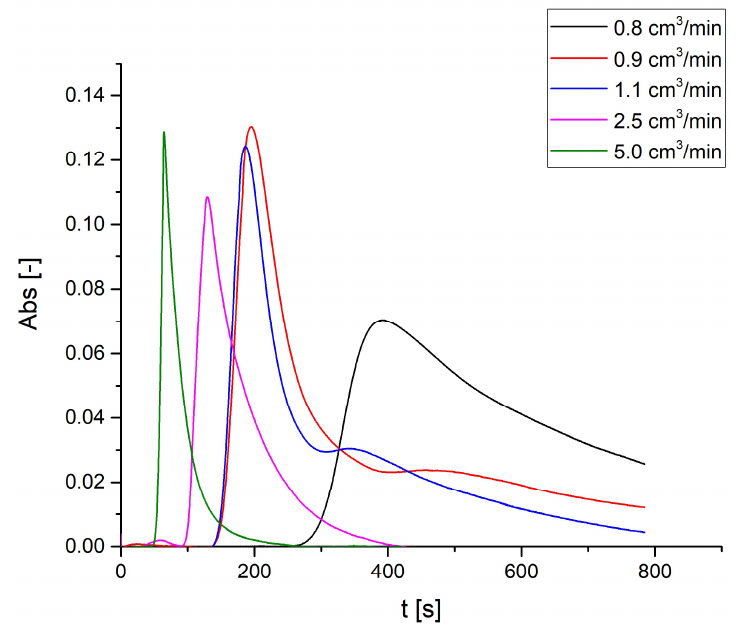
Figure 2. UV spectra of LA 6 M injected in the chromatographic reactor working at 303 K and at different flow rates.